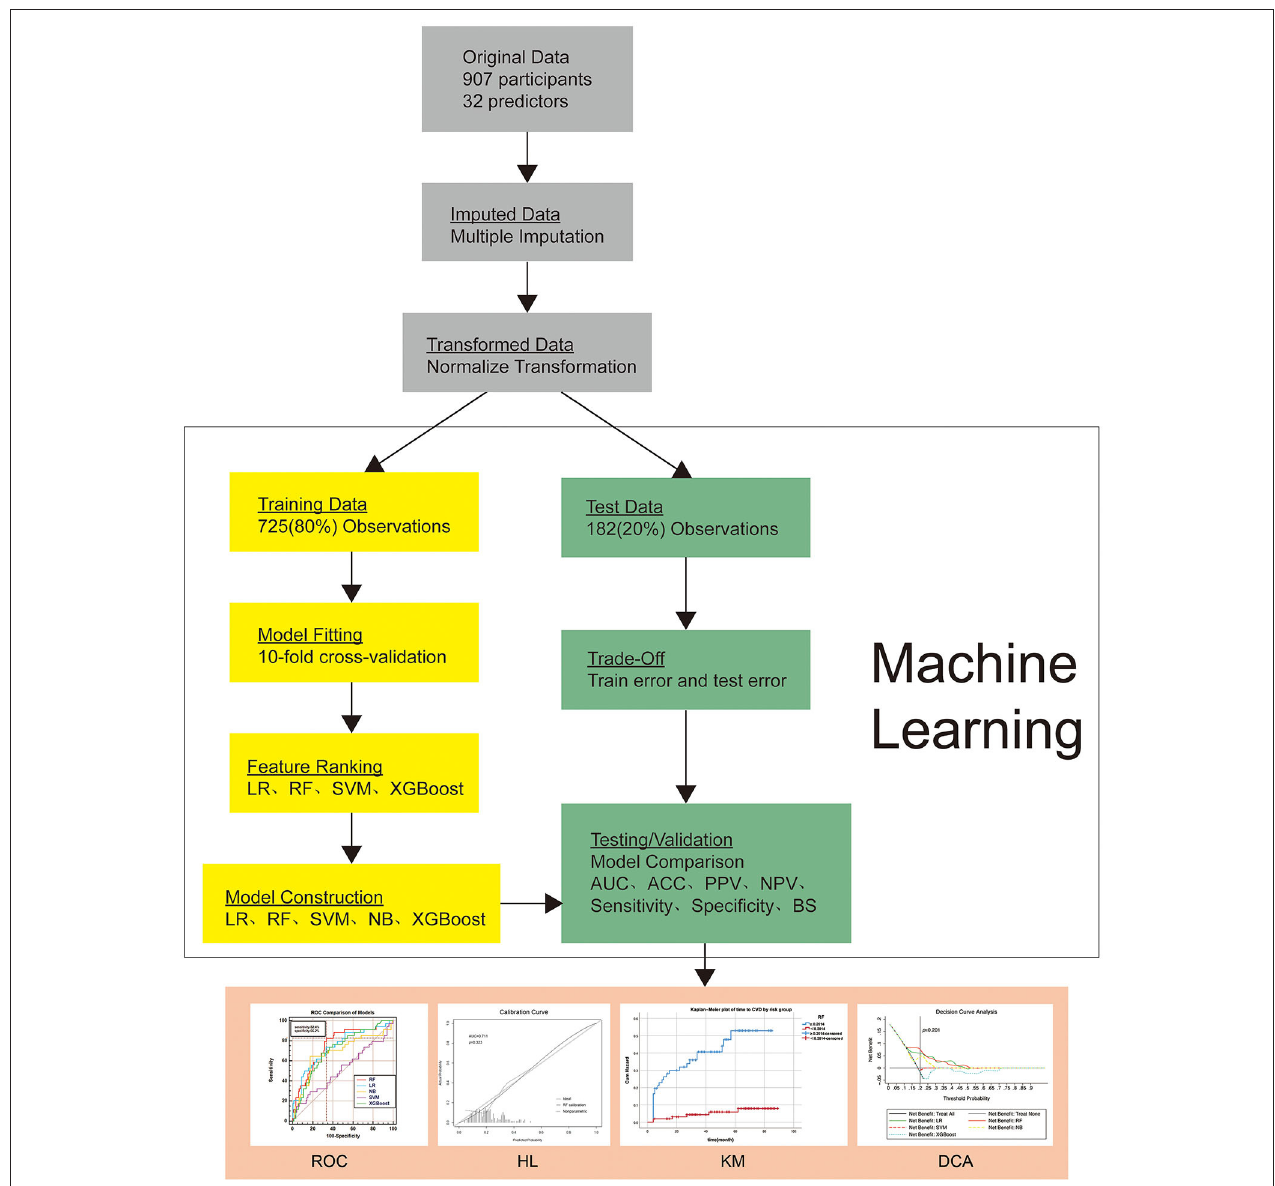
FIGURE 2 | Overview of the methods used for data extraction, training, and testing. ROC, Comparison of ROC AUC of five machine learning algorithms; KM, Kaplan–Meier plot of time to CVD by risk group; DCA, Decision curve analysis curve for the five machine learning algorithms. HL, Hosmer-Lemeshow goodness-of-fit test of the Random Forest model in the validation set. DCA: The y-axis measures the net benefit. Gray line (Treat None) represents the net benefit of outcomes (postpartum CVD) of non-intervention for all pregnant women; Black line (Treat All) represents the net benefits of outcomes of intervention for all pregnant women; Lines in different colors represent the risk stratification of preeclamptic women according to different machine learning algorithms. When intervention is given to high-risk women, the net benefit of postpartum CVD risk may be generated. The model with the highest net income under a specific threshold has the highest clinical value. CVD, Cardiovascular disease; LR, Logistic Regression; RF, Random Forest; SVM, Support Vector Machines with Linear Kernel; NB, Naive Bayes; XGBoost, Extreme Gradient Boosting algorithm; AUC, area under the curve; ACC, accuracy; BS, Brier Score; PPV, positive predictive values; NPV, negative predictive values; ROC, receiver operating characteristic curve; KM, Kaplan–Meier curve; DCA, decision curve analysis.